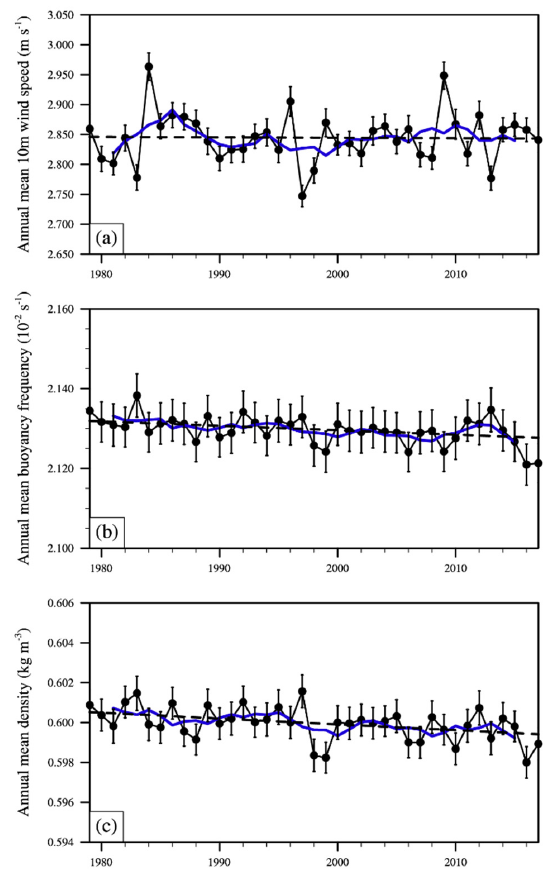
Figure 7. Time series of annual mean ( a ) 10-m wind speed, ( b ) buoyancy frequency and ( c ) air density at the surface over the TP during 1979–2017. Error bars represent standard errors. Blue lines are the 5-yr running average. Black dashed lines in ( a – c ) are the linear trends during 1979–2017.